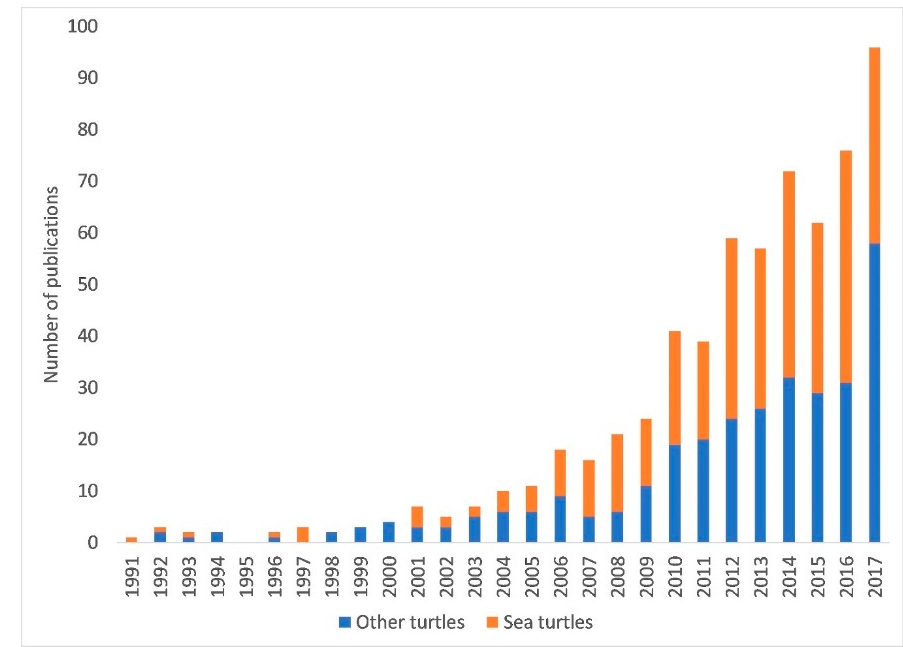
Figure 1. The number of published papers related to climate change and chelonians has increased substantially during the 21st century. This figure summarizes the number of published studies per year (resulting from an ISI (Institute for Scientific Information) Web of Science search on 8 August 2019) containing the search terms “turtles OR tortoises OR chelonian” and “climate change or global warming”, as well as the search terms “sea turtle OR Chelonia OR Caretta OR Eretmochelys OR Dermochelyis OR Lepidochelys OR Natator” and “climate change or global